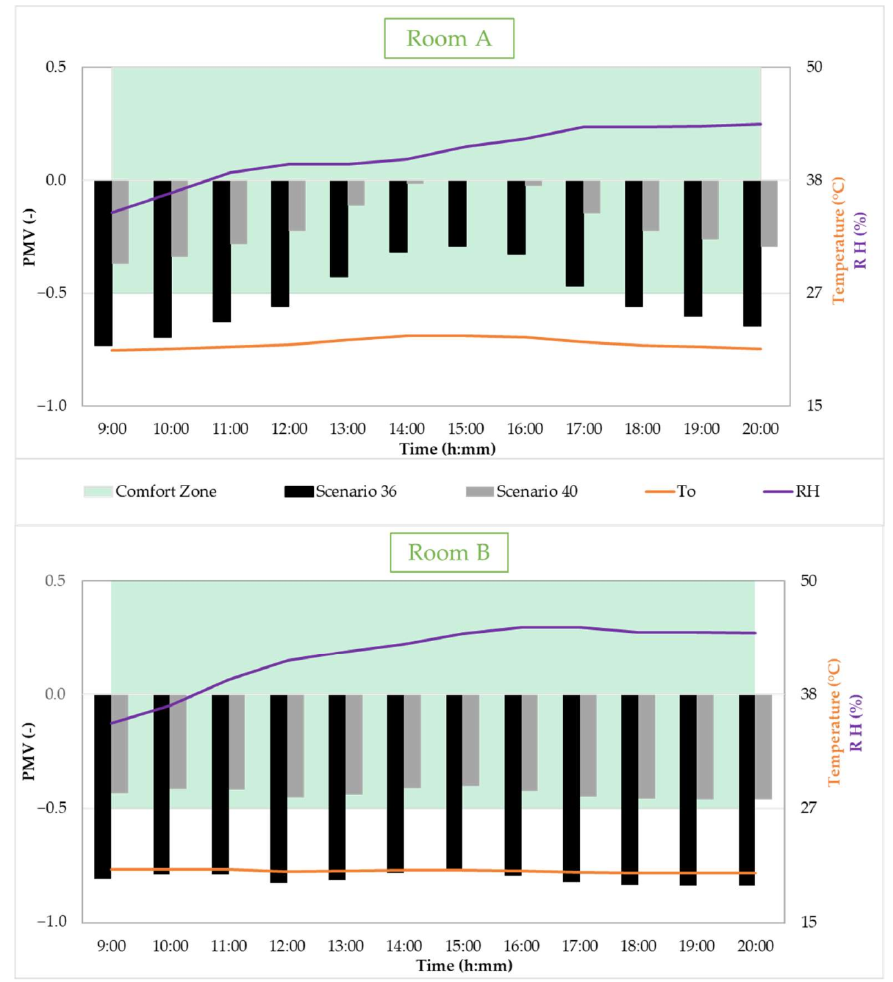
Figure 20. Hourly operative temperature, relative humidity, and PMV in rooms A and B with an out-of-bed patient: different scenarios in the winter